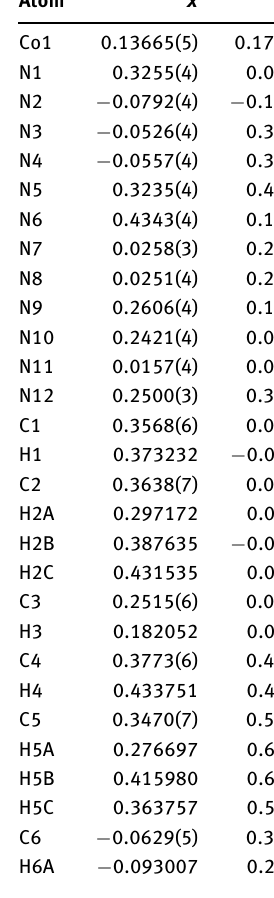
Table 2: Fractional atomic coordinates and isotropic or equivalent isotropic displacement parameters (Å 2